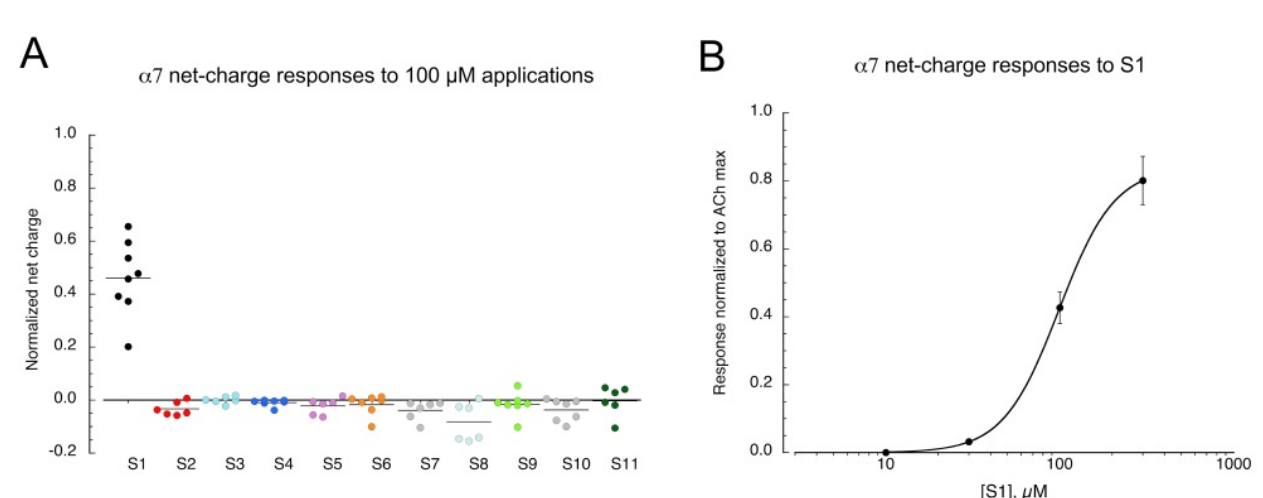
Figure 2. Responses of α 7 nAChR to sulfonium compounds. ( A ) Net-charge responses to the applications of the test compounds applied at 100 µ M. Net charge was calculated as the integrated area of inward current over a 120 s interval following the 30 s-pre-application period used to establish an initial baseline. Note that points less than zero do not represent outward current responses, per se, but rather reductions in the holding current during the post application period. ( B ) Averaged net-charge responses ( ± SEM, n = 8) to applications of S1 across a range of concentrations. Responses were measured relative to preceding 60 µ M ACh control responses and then adjusted for the difference between ACh controls and ACh maximum responses. See text for curve-fit values.